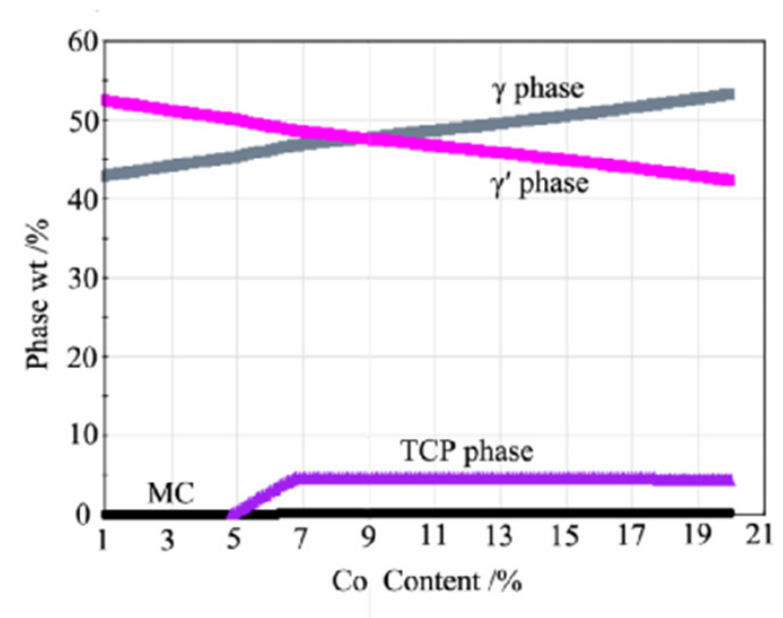
Figure 12. The effect of Co content on the equilibrium phases at 1100 °C.